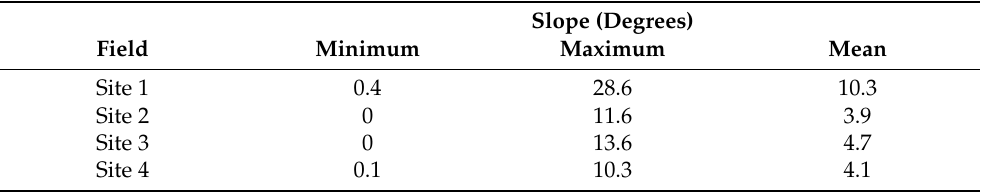
Table 2. Minimum, maximum, and mean field slopes for each of the harvested sites.